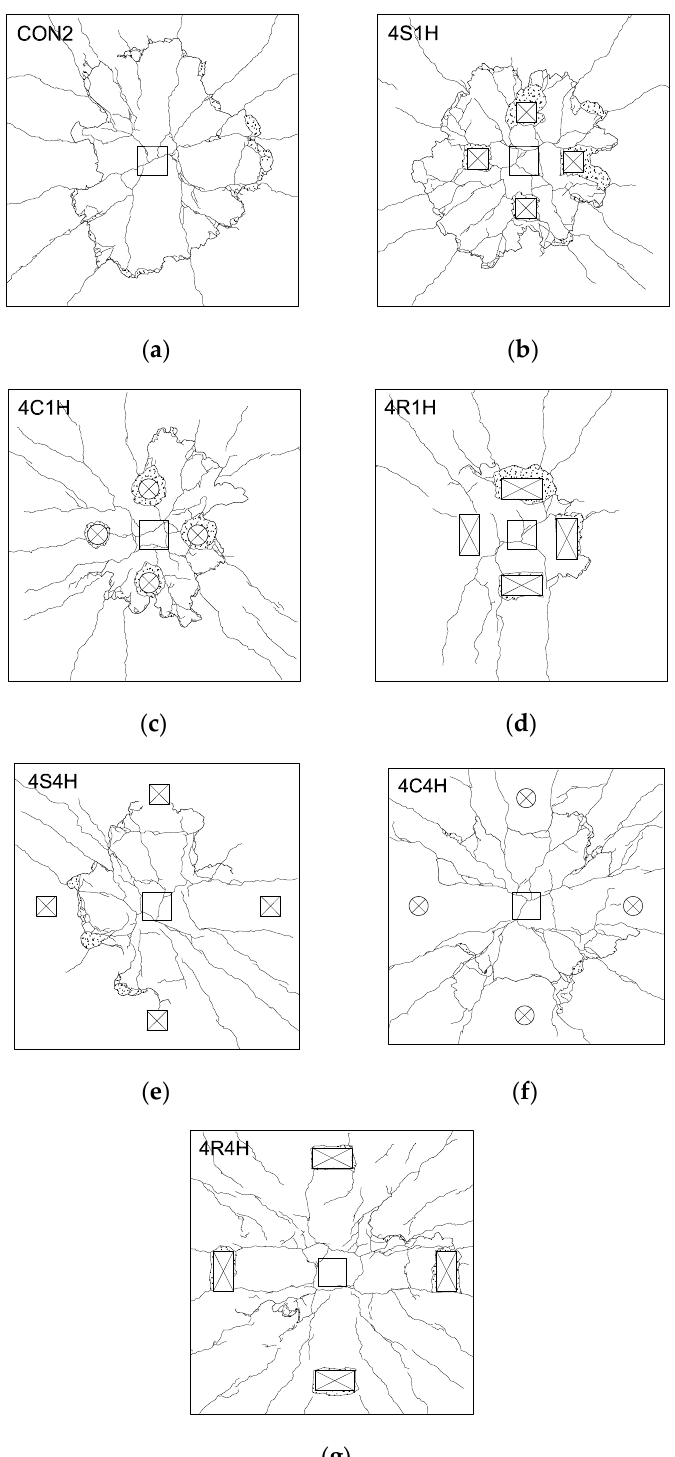
Figure 10. Crack patterns at failure for group 2 (Line diagrams). ( a ) Specimen CON2; ( b ) Spec- imen 4S1H; ( c ) Specimen 4C1H; ( d ) Specimen 4R1H; ( e ) Specimen 4S4H; ( f ) Specimen 4C4H; ( g ) Specimen